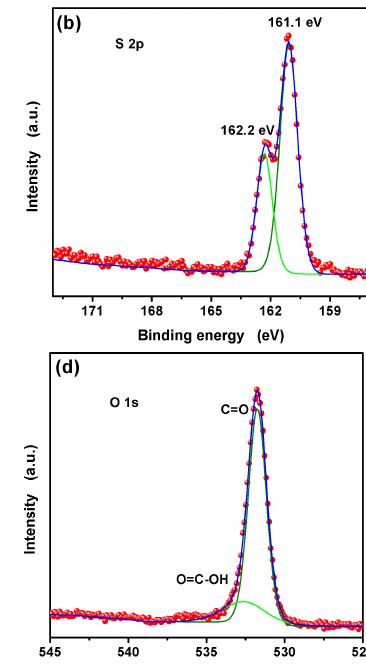
Figure 3. FTIR spectra of L-Asp (black line) and L-Asp@CdS QDs (red line).